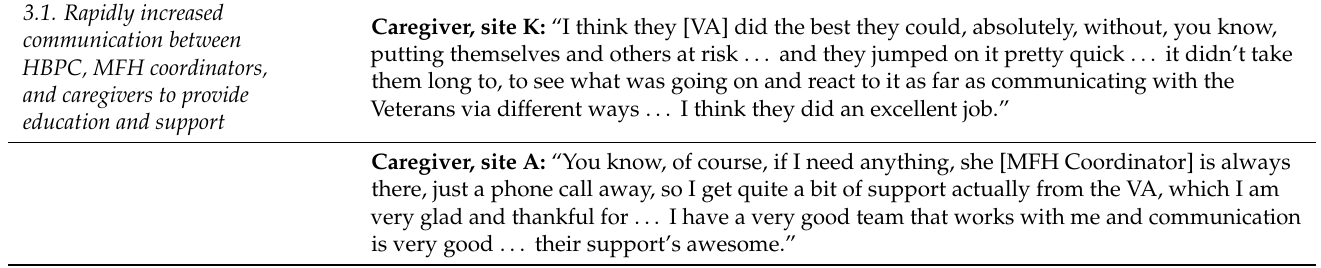
Table 2. Illustrative Quotations Reflective of Themes from the Study